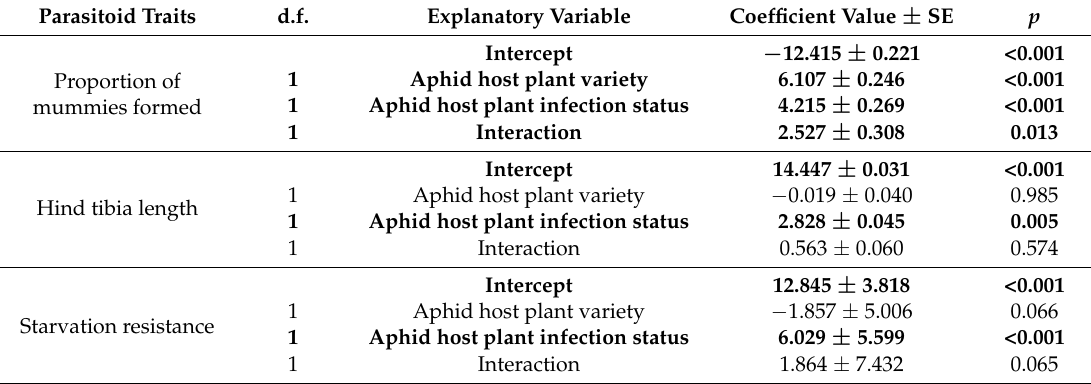
Table 4. Summary of effects of asymptomatic B. cinerea infection status and plant variety on parasitoid traits following analysis. Significant values are in